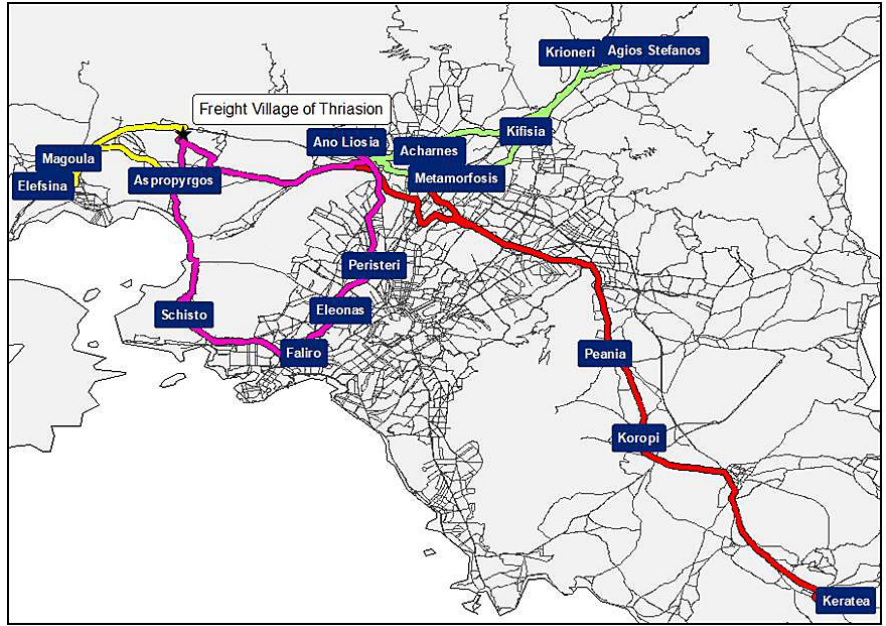
Fig. 5. Transportation network and reference